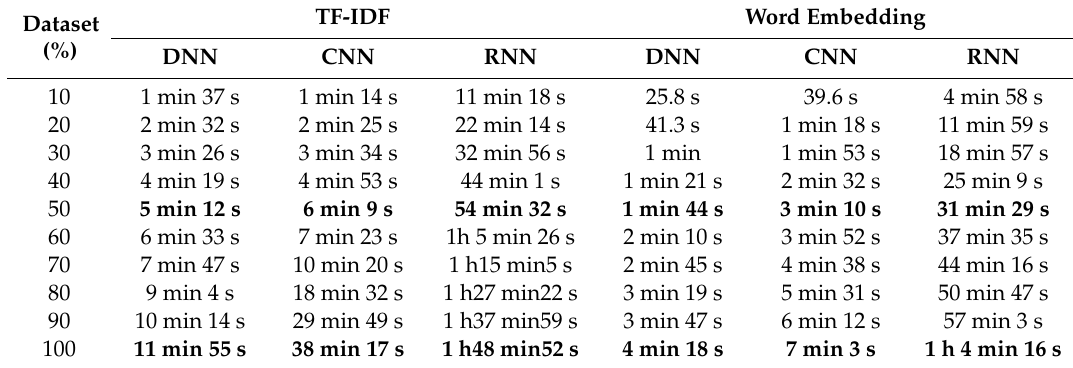
Table 7. CPU times of experiments with numbers of tweets with a GPU.